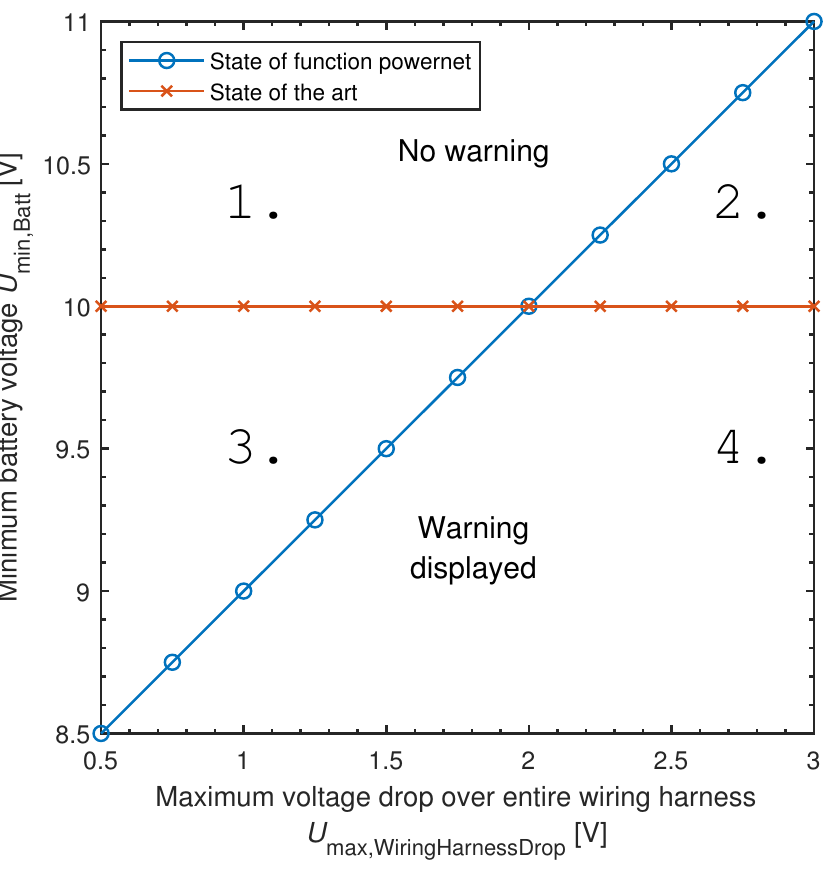
Figure 11. Comparison of the warning threshold for different powernet states between the state of the art and SOFPN for the evaluation of